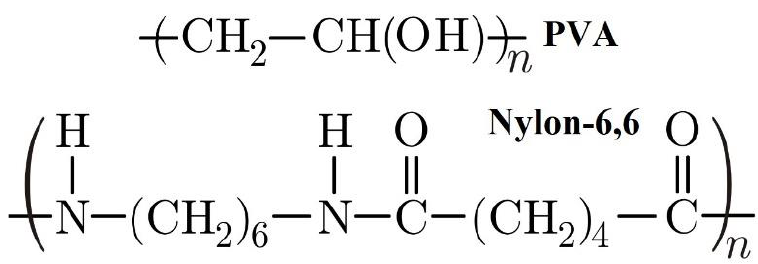
Figure 1. The chemical structure of PVA and Nylon-6,6 polymers.